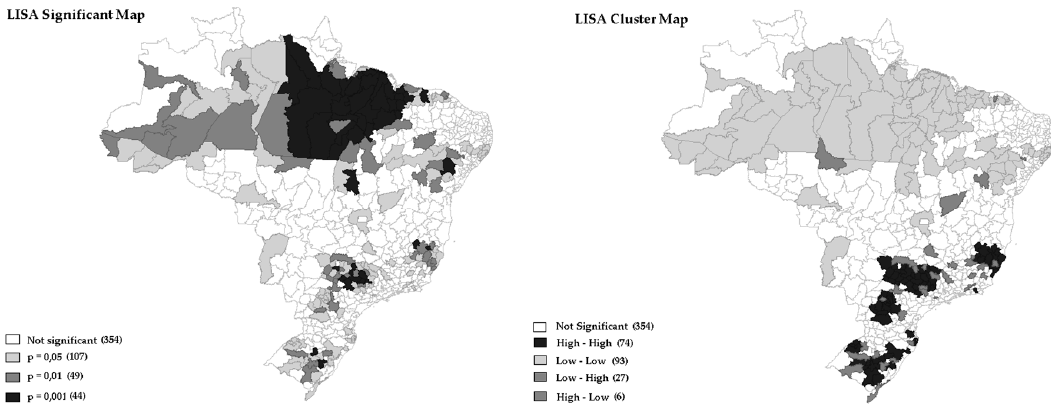
Figure 3. Univariate Local Moran’s by LISA of oral and oropharynx cancer weighted by male, Brazil, 2016.